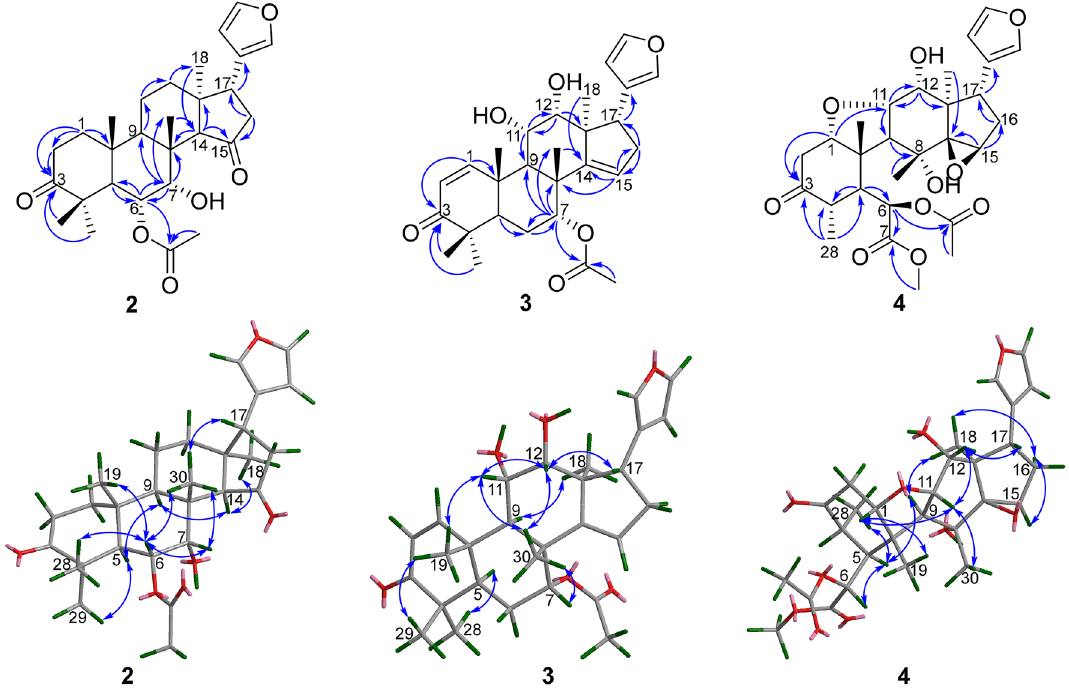
Fig. 3 The key HMBC and ROESY correlations of compounds 2 −